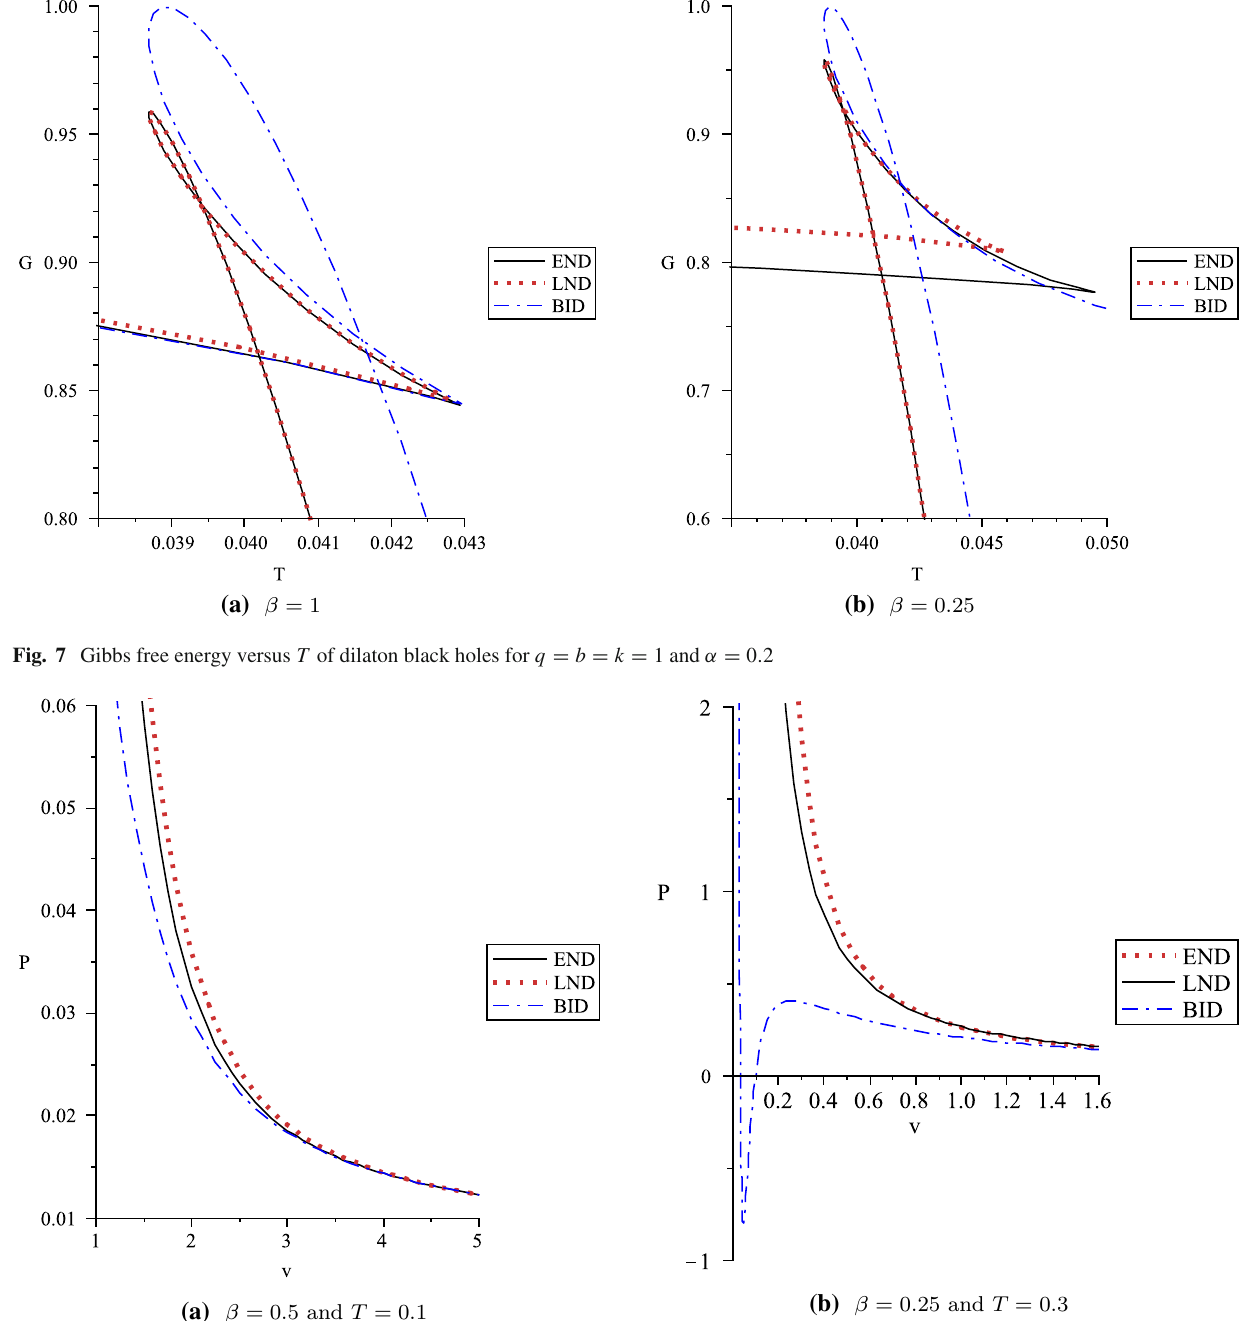
Fig. 8 P – v diagram of dilaton black holes with different electrodynamics. Here we have taken α = 0 . 3 and q = b = k =